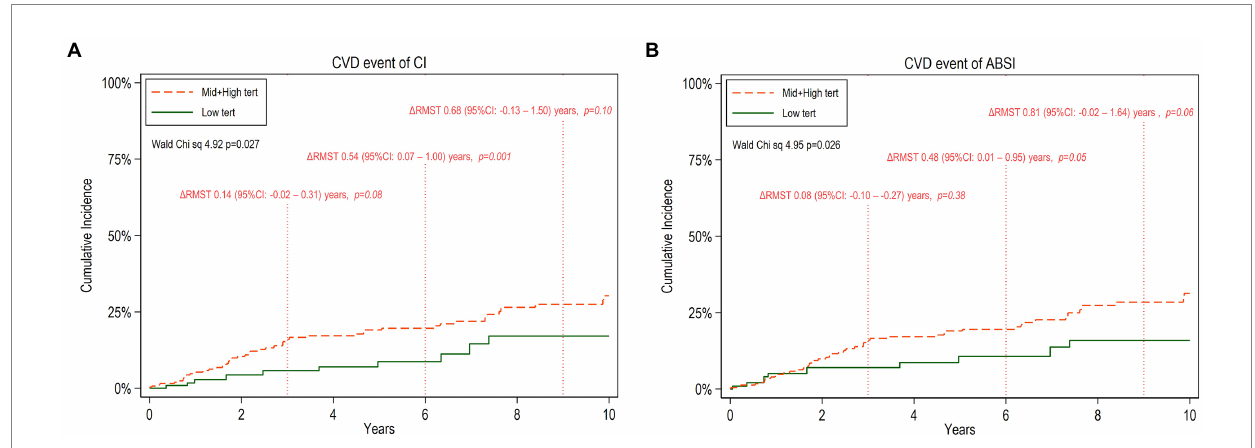
FIGURE 1 Cumulative incidence of cardiovascular disease (CVD) events during 10 years of follow-up among CKD5 patients with low tertiles versus high and middle tertiles of CI (A) and ABSI (B) respectively. The mean difference of restricted mean survival time, Δ RMST (95% confidence interval, 95%CI) between the two tertile groups at truncation time 3,6 and 9 years, respectively, is noted.